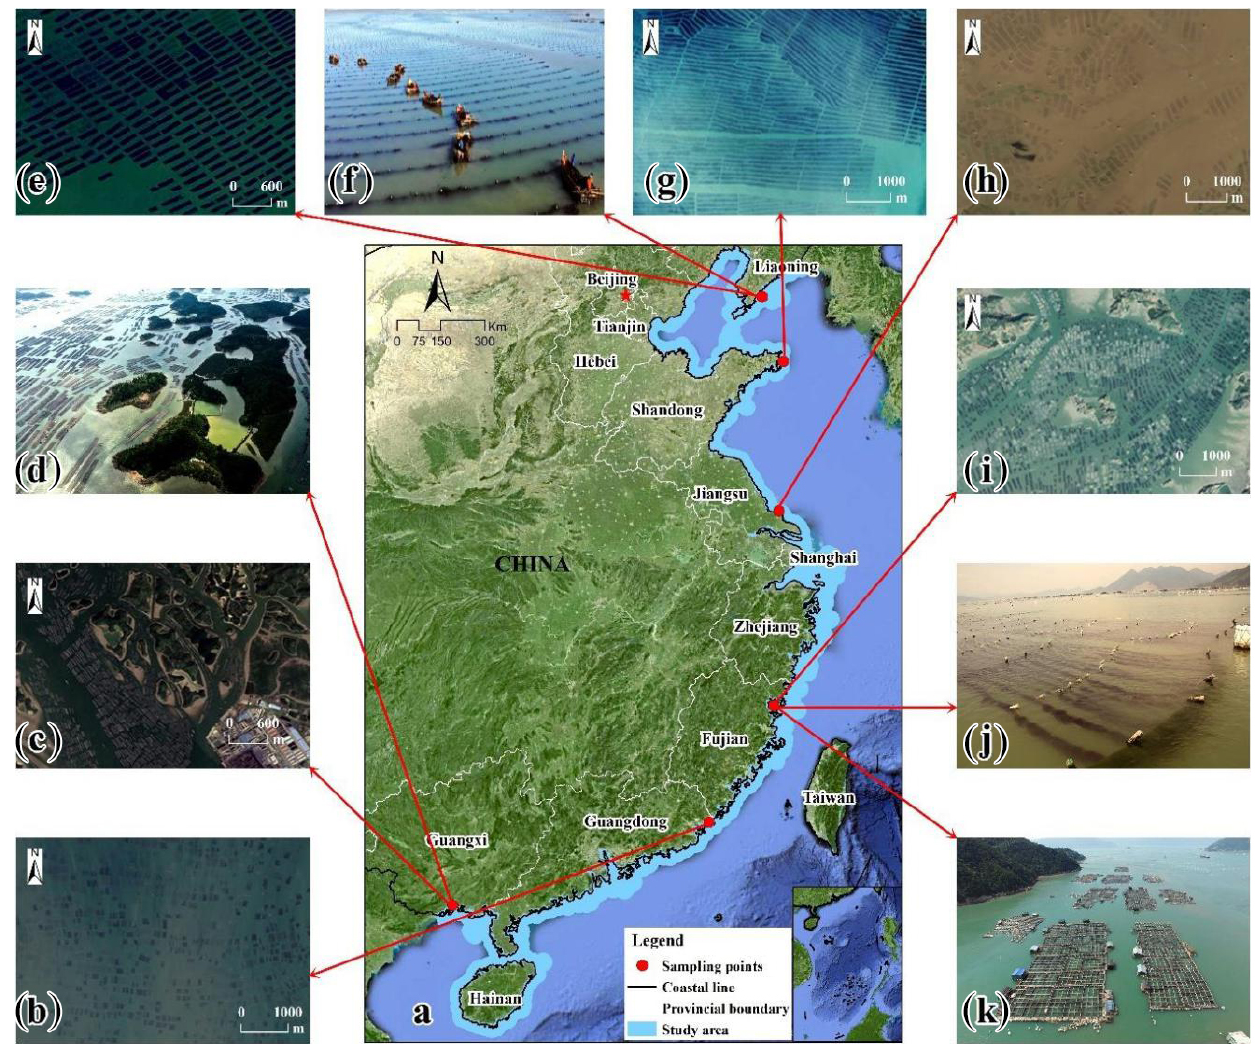
Figure 2. Location of the sampling points (a) . Image examples of typical marine aquaculture areas on ground or from high-spatial-resolution (HSR) images. (b, e, g, h, i) Marine plant culture (MPC) areas from HSR images. (c, i) Marine animal culture (MAC) areas from HSR images. (d, k) Photos of MAC areas on ground. (f, j) Photos of MPC areas on